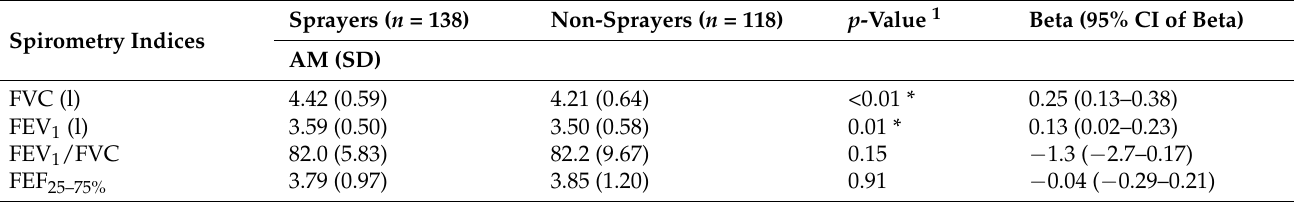
Table 4. Spirometry indices among spraying and non-spraying flower farm workers in Ethiopia ( n =